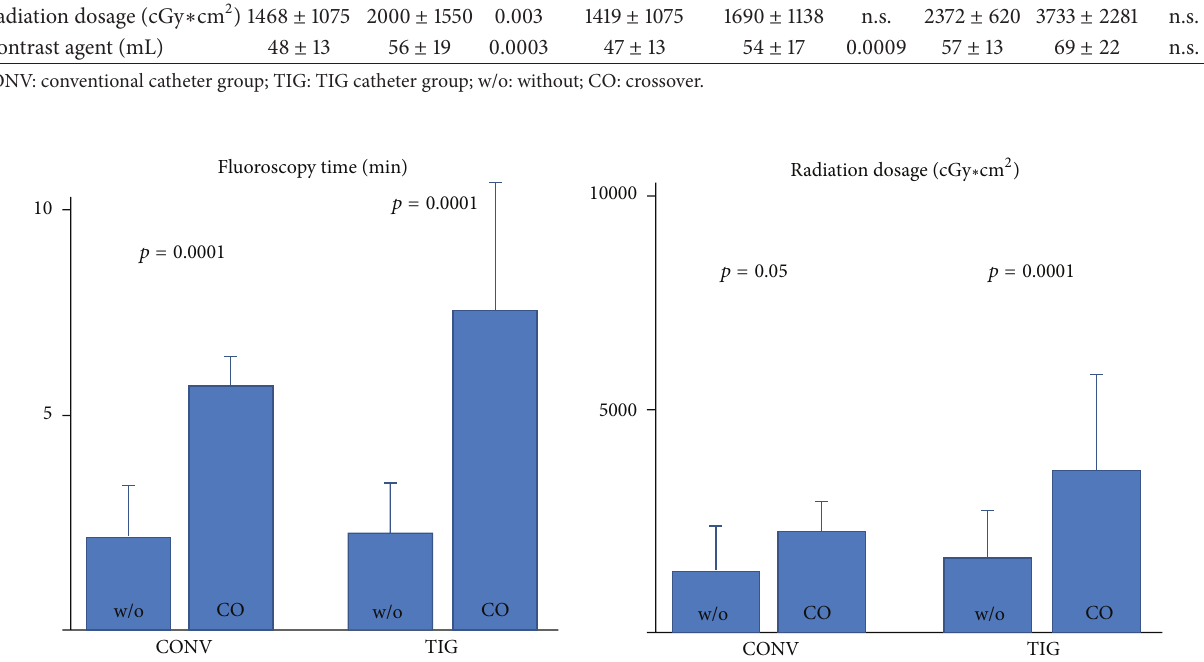
between CONV and TIG, without crossover ( 1419 ± 1075 versus 1690 ± 1138 ; n.s.) (Table 2 and Figure